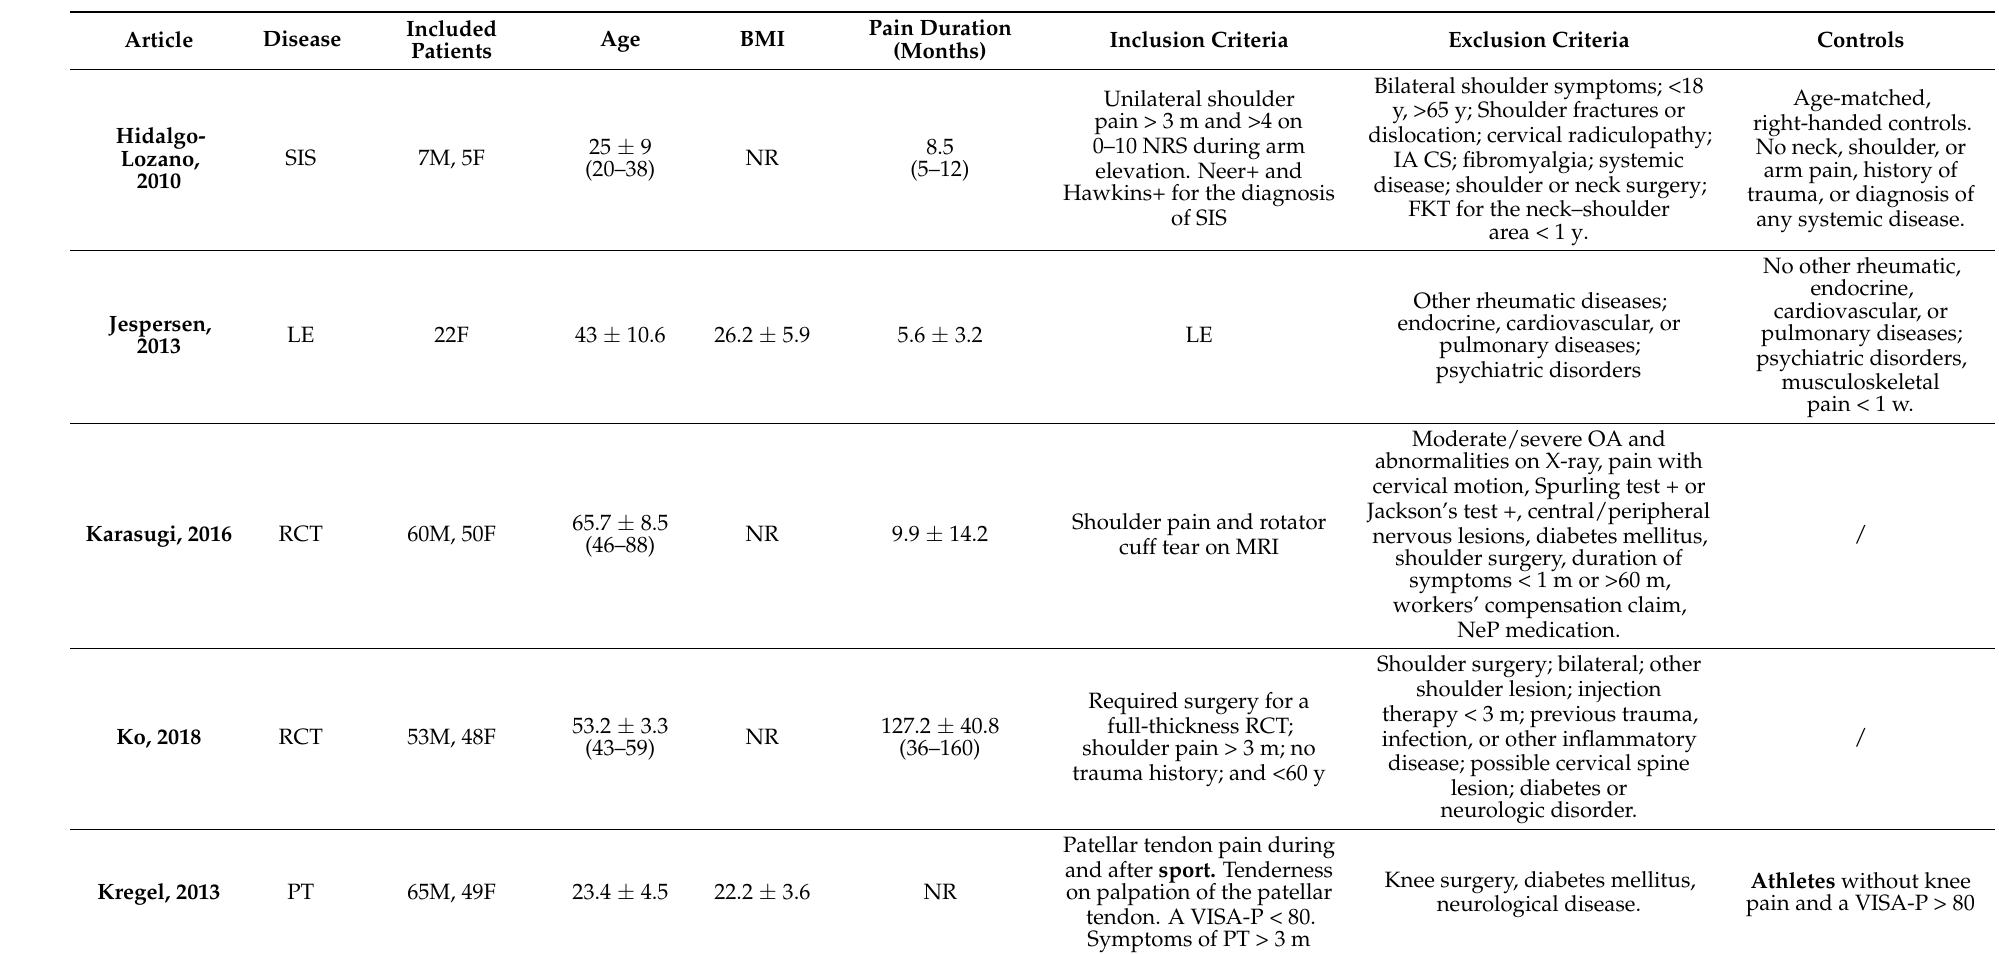
Athletes without knee pain and a VISA-P >